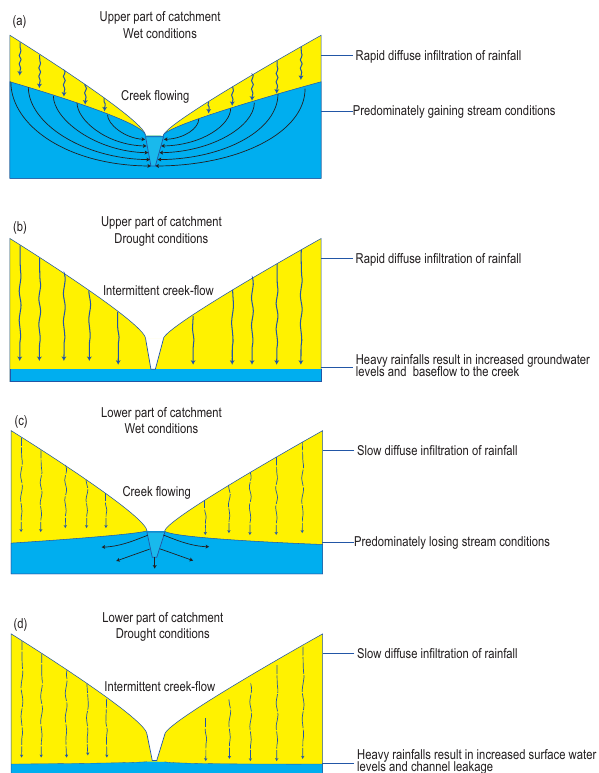
Figure 10. Conceptual model of recharge processes in the (a) upper part of catchment during wet conditions; (b) upper part of catch- ment during drought conditions; (c) lower part of catchment during wet conditions; and (d) lower part of catchment during drought con-